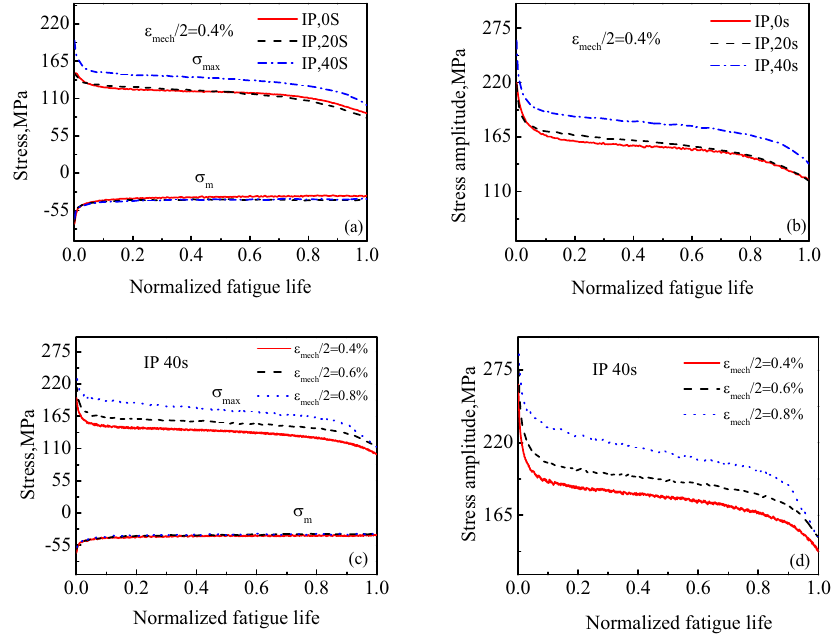
Figure 5: Cyclic response of ( a ) maximum stress σ max and mean stress σ m and ( b ) stress amplitude with di ff erent hold time, ( c ) maximum stress σ max and mean stress σ m , and ( d ) stress amplitude with di ff erent mechanical strain